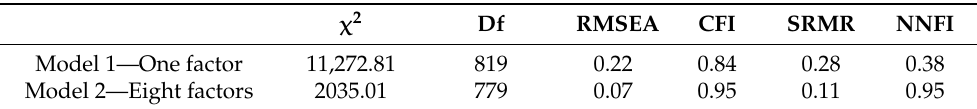
Table 2. Alternative measurement models on study